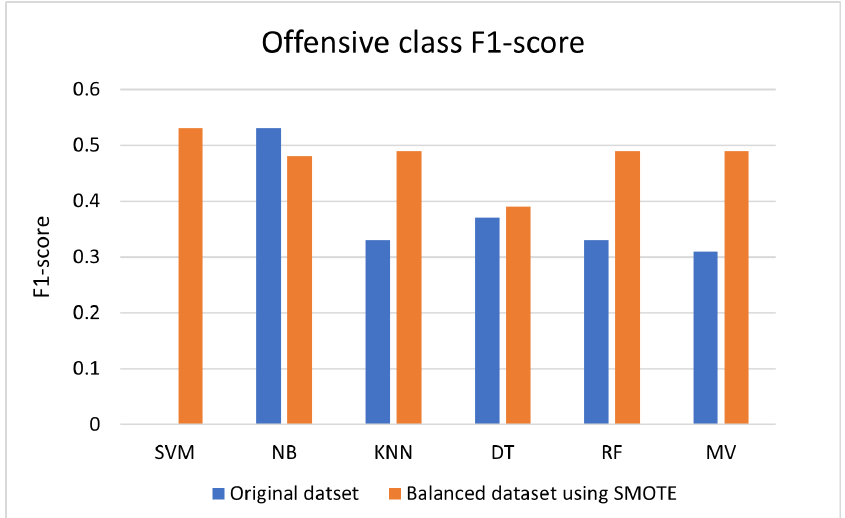
Figure 7. Offensive class F 1 -scores for original and balanced dataset